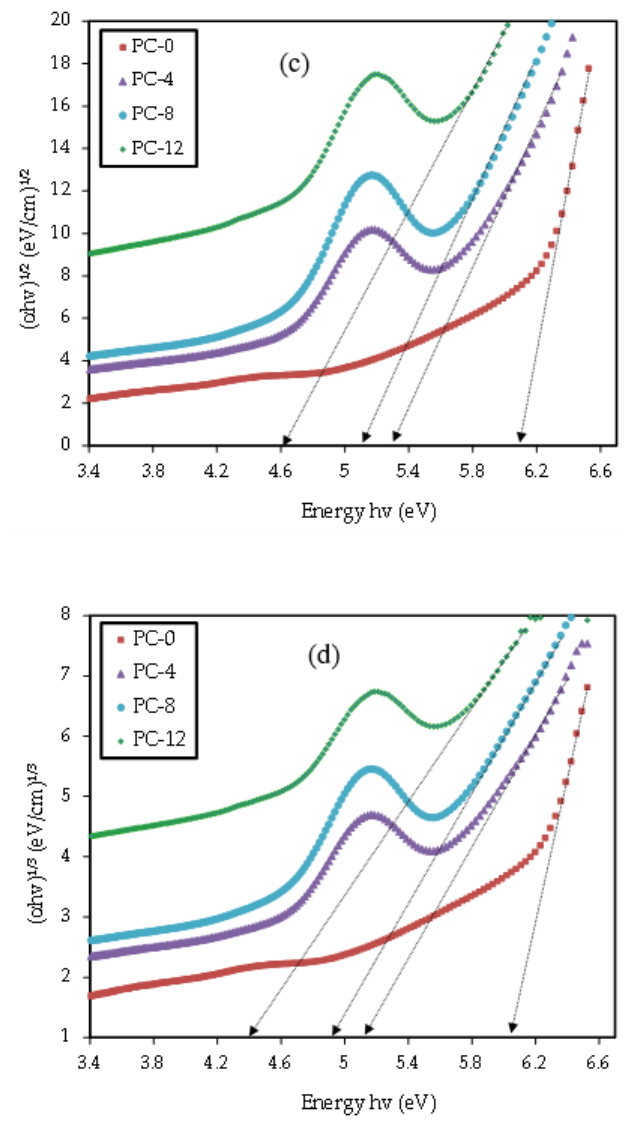
Figure 7. ( a ) (𝛼ℎ𝑣) (cid:2870) , ( b ) (𝛼ℎ𝑣) (cid:2870) (cid:2871)⁄ , ( c ) (𝛼ℎ𝑣) (cid:2869) (cid:2870)⁄ , and ( d ) (𝛼ℎ𝑣) (cid:2869) (cid:2871)⁄ versus ℎ𝑣 for PVA and doped Figure 7. ( a ) ( α hv ) 2 , ( b ) ( α hv ) 2/3 , ( c ) ( α hv ) 1/2 , and ( d ) ( α hv ) 1/3 versus hv for PVA and doped systems.